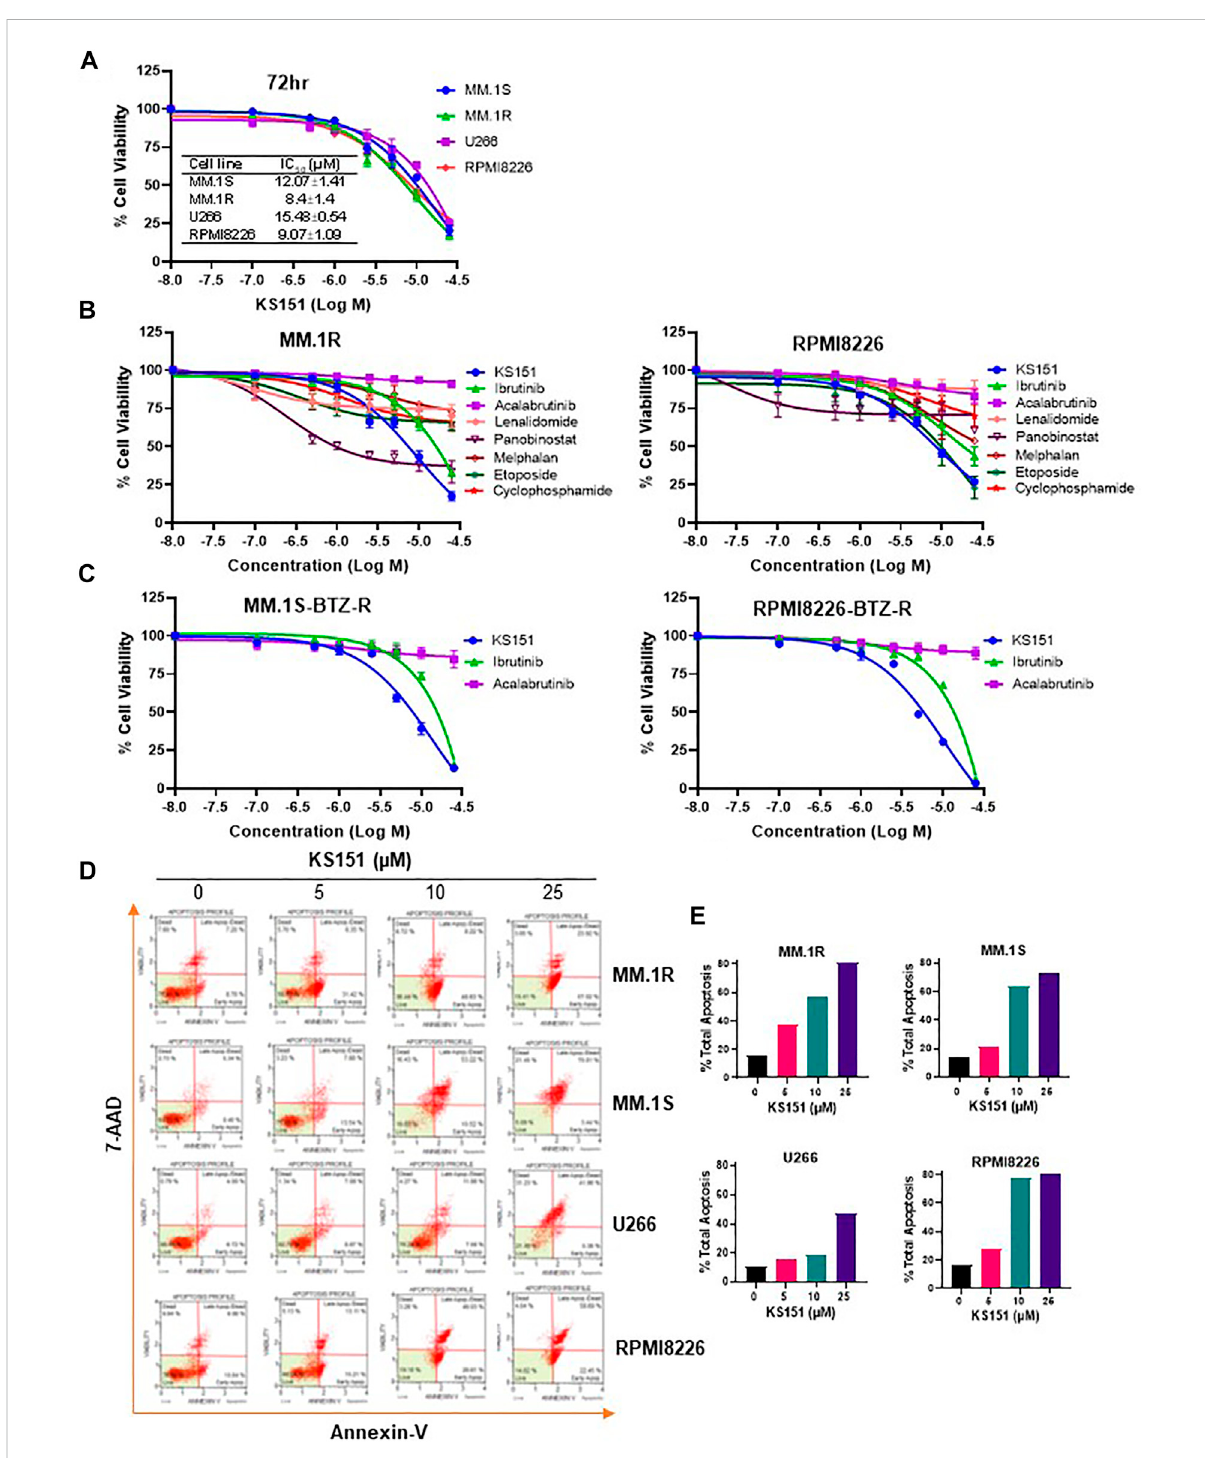
FIGURE 5 The cytotoxic effect ofKS151 on MM and bortezomib -resistant cells. (A) , Various MM cells weretreated with increasing amount (0.1 – 25 μ M) of KS151 for 72 h and cell viability was assessed by MTT as described in the materials and methods section. IC 50 was calculated by a non-linear regression plot. (B) , MTT cell viability assay investigating the proliferation of MM.1R and RPMI 8226 MM cell lines treated with different doses (0.1 – 25 μ M) of different chemotherapeutic agents (acalabrutinib, ibrutinib, lenalidomide, panobinostat, melphalan, etoposide, cyclophosphamide) as well as KS151 for 72 h. The cell viability was assessed by MTT as described in the materials and methods section. (C) , Bortezomib-resistant MM cells were treated with increasing amount (0.1 – 25 μ M) of KS151, ibrutinib, and acalabrutinib for 72 h and cell viability was assessedbyMTT. (D) ,AnnexinVstainingtodetectapoptoticcells.MM.1S,MM.1R,U266,andRPMI8226MMcellstreatedfor24 hwithdifferentdoses of KS151 and then stained with Annexin V dye and analyzed by the Muse Cell Analyzer. (E) , Quantitation of apoptotic cells (early plus late apoptosis) after treatment as detected by Annexin V